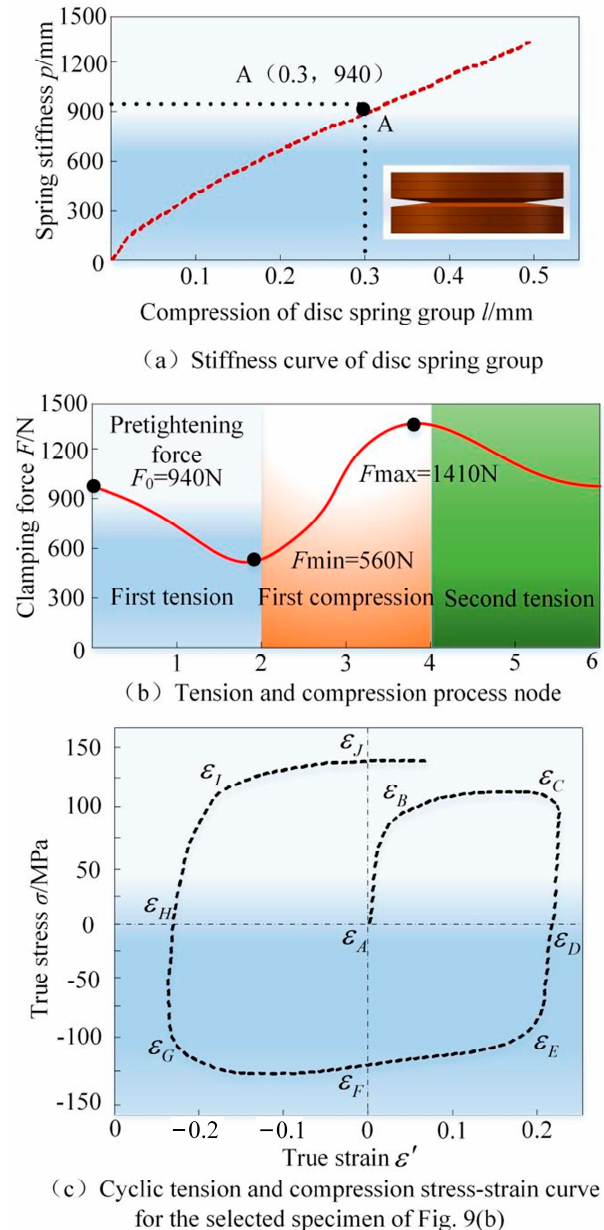
Figure 10. ( a ) Stiffness curve of butterfly spring group/mm; ( b ) tension and compression process node; ( c ) cyclic tension and compression stress–strain curve for the selected specimen of Figure 9b.